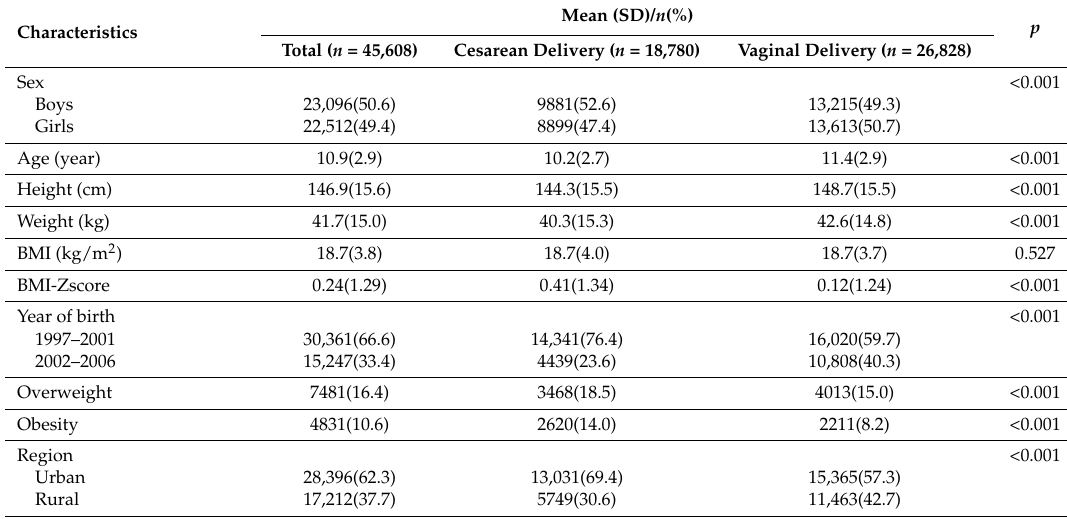
Table 1. Characteristics of children and adolescents by different delivery